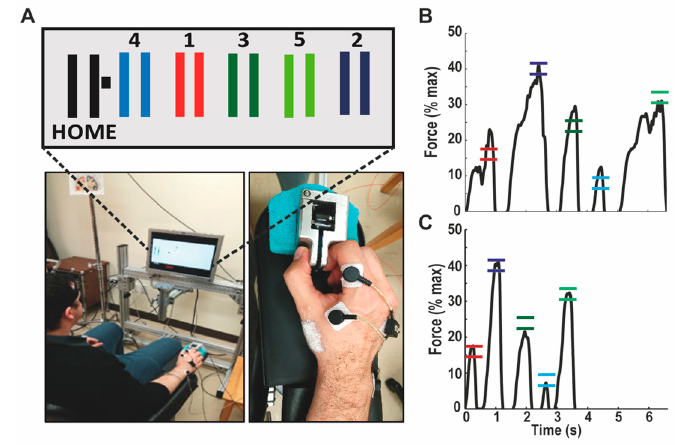
Figure 2. Description of the motor task. ( A ) Pinching a force transducer with the right thumb and index allowed the subject to control the position of the cursor (black square) on the computer screen. The horizontal displacement was normalized against the maximal voluntary force of the subject. Home corresponded to 0% and Gate 2 corresponded to 40% of maximal force. Subjects were required to execute the sequence (Home-1-Home-2-Home-3-Home-4-Home-5-Home) as quickly and as